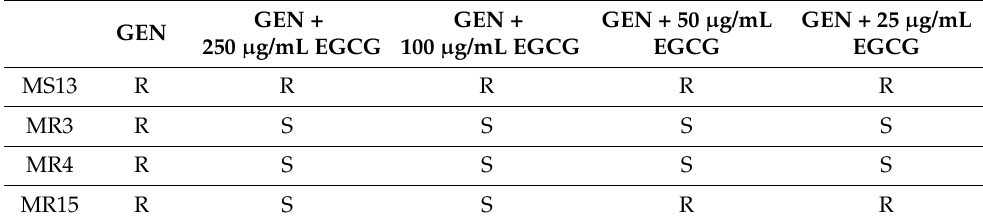
Table 1. Resistance profile of isolated MSSA (MS13) and MRSA (MR3, MR4, MR15) strains resistant to gentamycin (30 µ g) after co-exposure with EGCG at final concentrations of 250 µ g/mL, 100 µ g/mL, 50 µ g/mL and 25 µ g/mL. Antibiotic susceptibility was assessed using the disk diffusion method using EUCAST Clinical Breakpoint Tables v. 10.0, valid from 1 January 2020